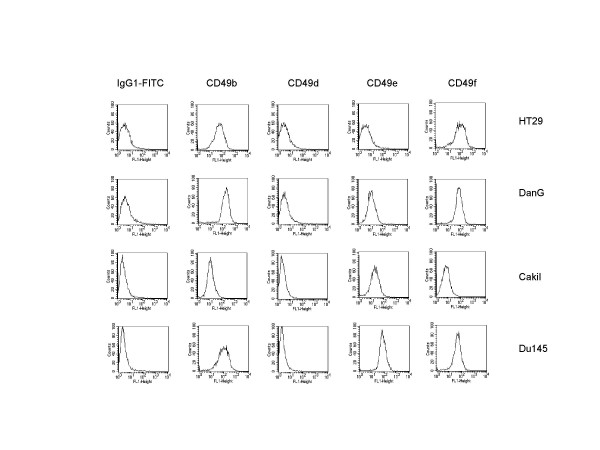
FACS analysis of beta1 integrin surface expression on HT-29, DanG, Caki I, and DU-145 tumor cells. Tumor cells were washed in blocking solution and then stained with the FITC-conjugated monoclonal antibody anti-alpha2beta1 (CD49b; clone AK-7), anti-alpha4beta1 (CD49d; clone HP2I1), anti-alpha5beta1 (CD49e; clone SAM-1), or anti-alpha6beta1 (CD49f; clone GOH3). A mouse IgG1-FITC was used as an isotype control for FITC conjugated antibodies. Fluorescence was analyzed using a FACScan flow cytometer, and a histogram plot (FL1-Height) was generated to show FITC-fluorescence.